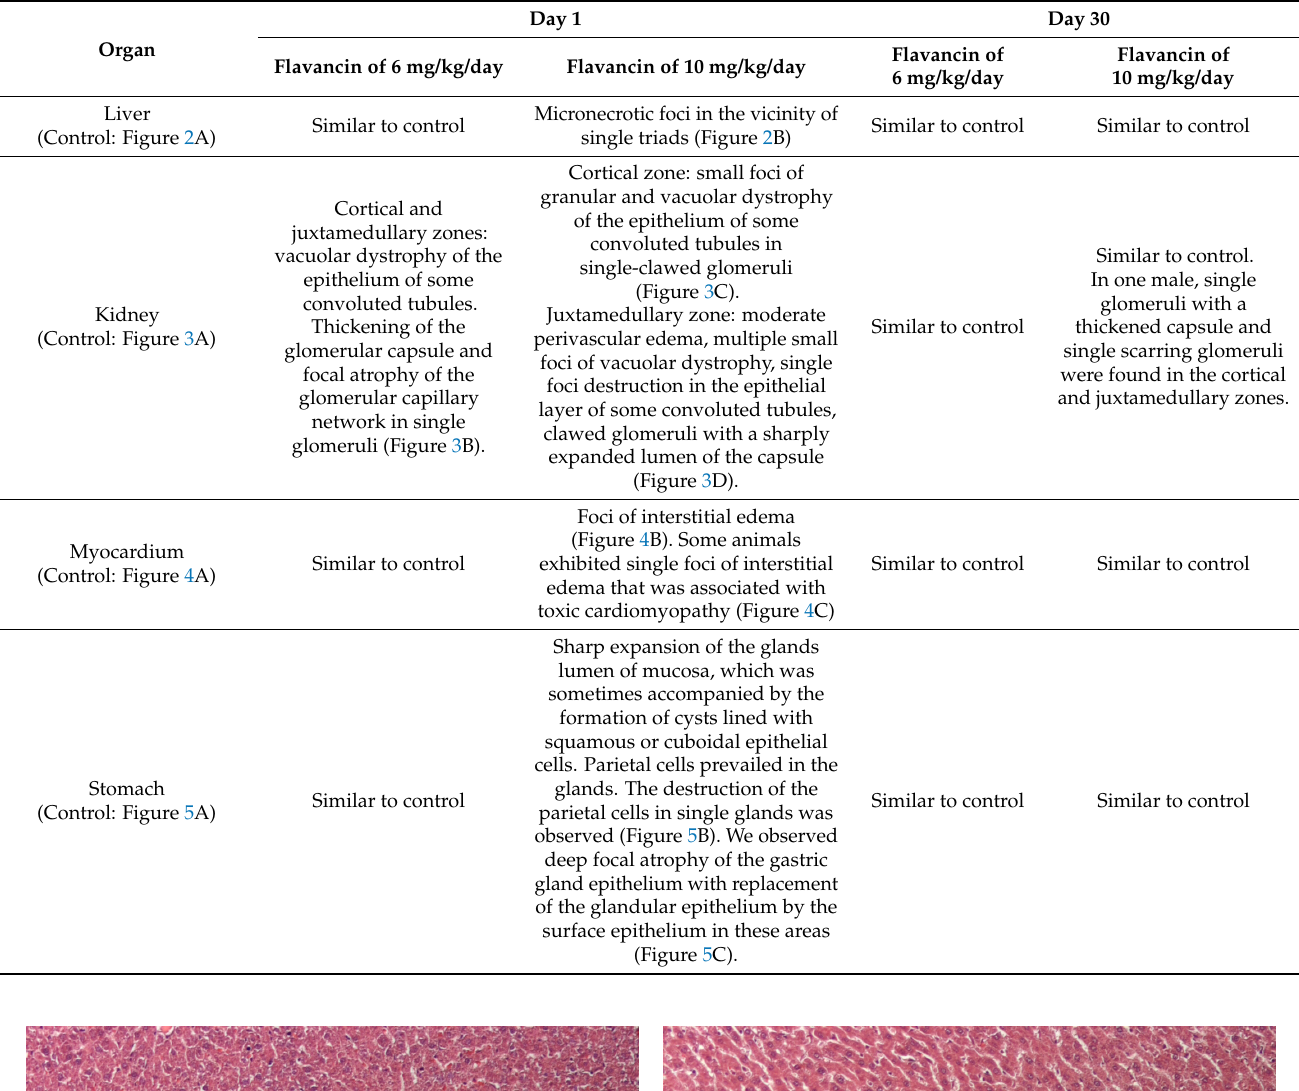
Table 3. Pathomorphological findings after flavancin on days 1 and 30 post-treatment.